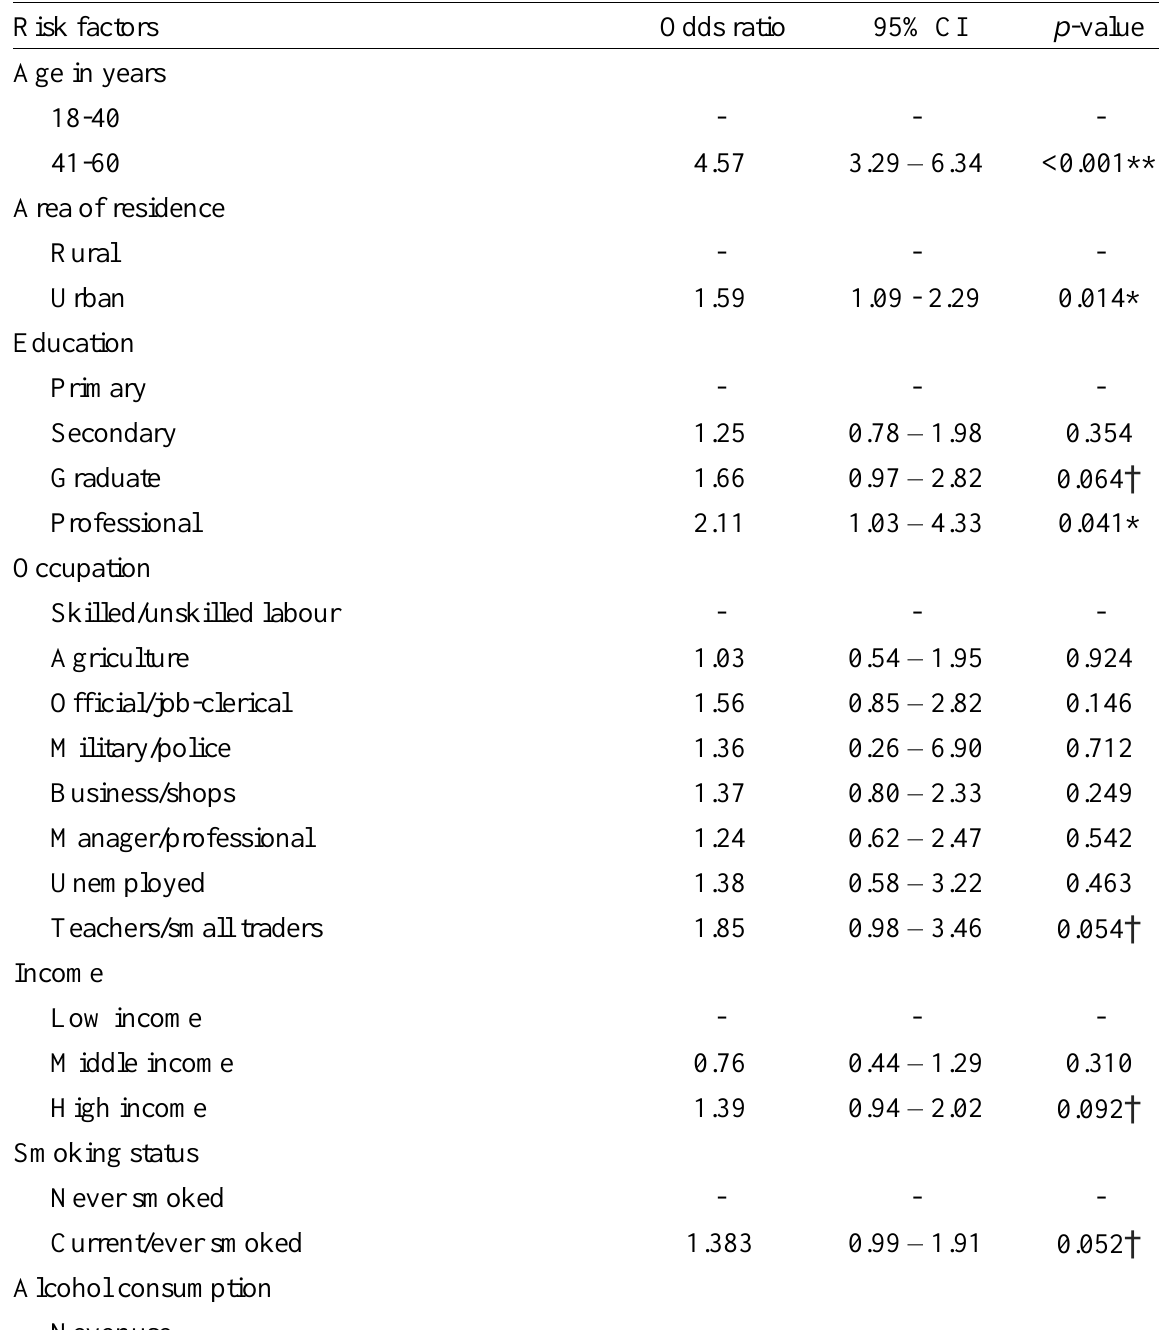
Table 2.Bivariate logistic regression analysis of predictors of cardiovascular